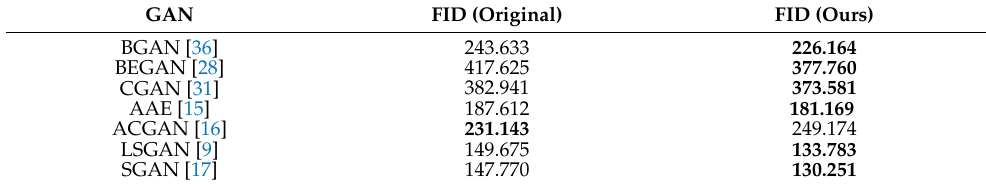
Table 3. Score (FID) test on GANs (Cifar-10).